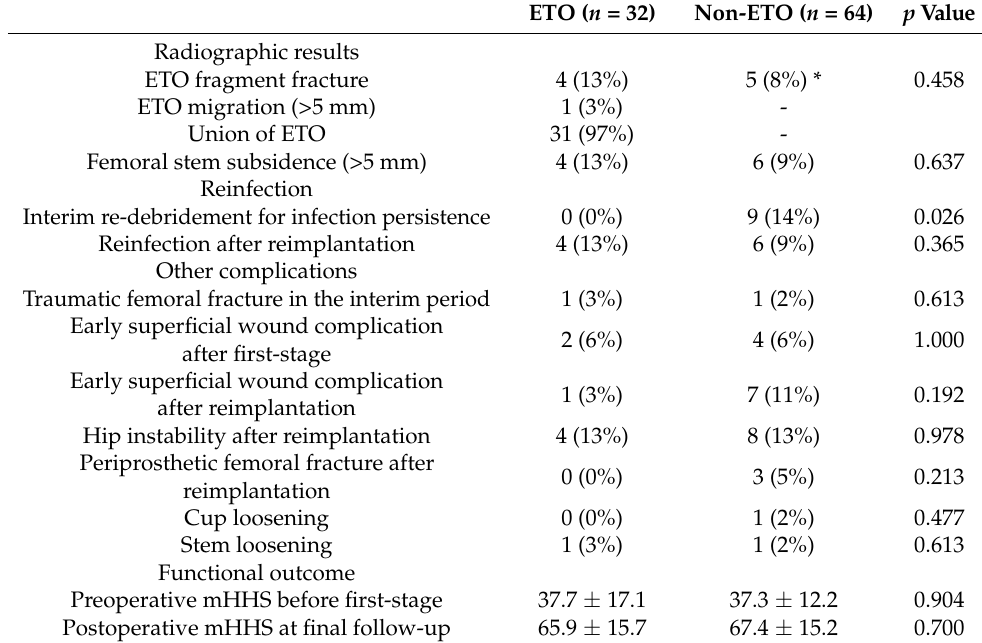
Table 4. Comparison of radiographic results, complications and functional outcome between ETO and non-ETO